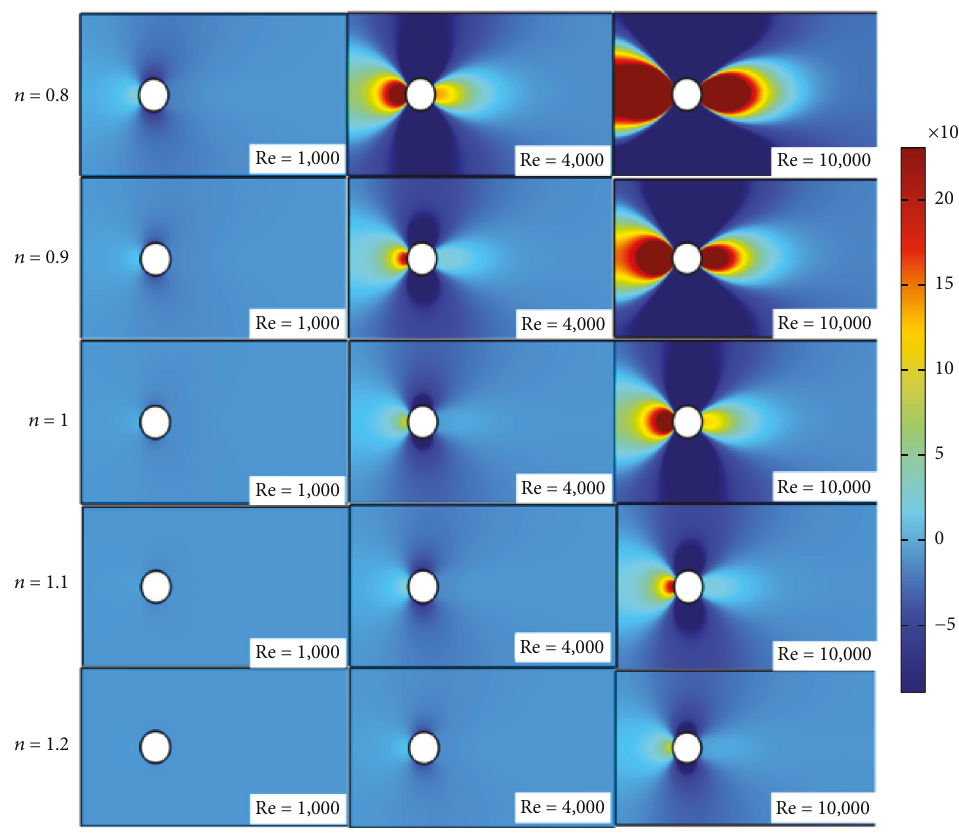
Figure 7: Pressure distribution near the heated cylinder with radius r � 0 . 1m.